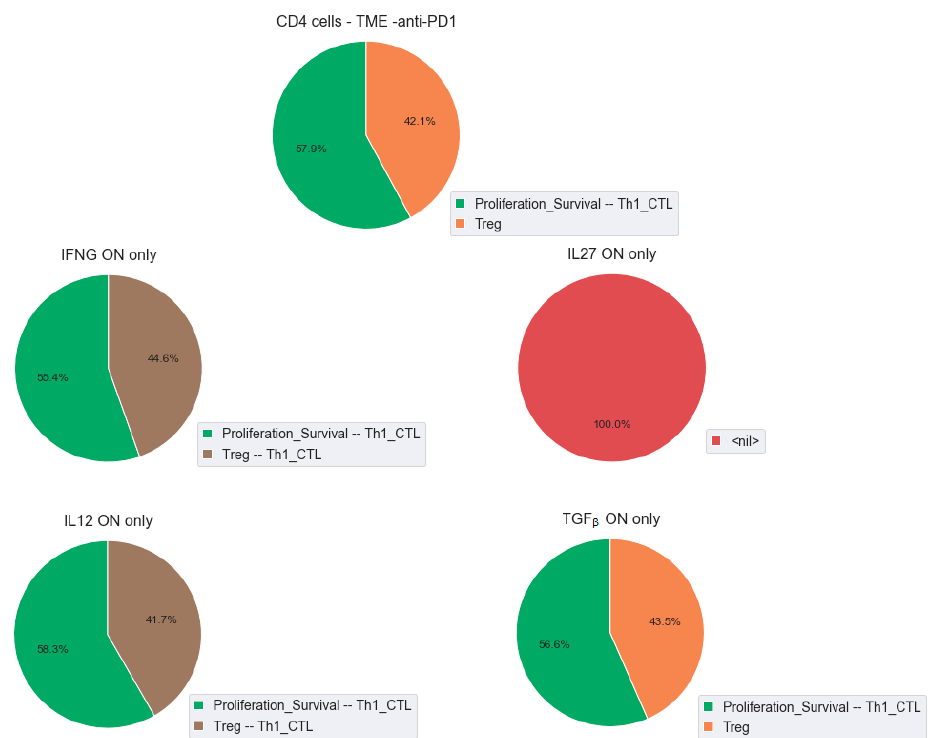
Figure 4. E ff ect of cytokines on CD4 + cells. CD4 + cells: in the absence of the cytokines (top panel), in the presence of IFNG only (middle left panel), IL12 only (bottom left panel), IL27 only (middle right panel), TGF β only (bottom left panel). In the legend, the presence of a phenotype means that it corresponds to the asymptotic solution of the simulations in all the conditions. If Treg is mentioned, it should be understood as: Treg is ON, but Proliferation_Survival and Th1_CTL are OFF.